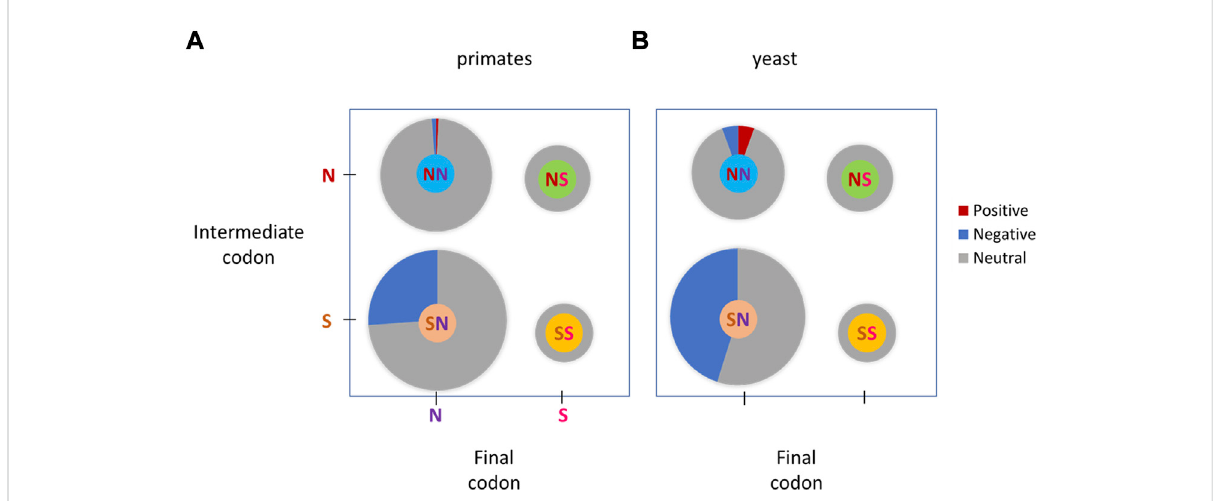
FIGURE 4 Selective pressure in different codon double substitutions classes. Positive, combinations compatible with positive selection, where a codon double substitution has a signi fi cantly higher DF than the corresponding DF of a null model (NM1 or NM2). Negative, combinations compatible with purifyingselection,whereacodondoublesubstitutionhasasigni fi cantlylowerDFthanthecorrespondingDFofanullmodel.Neutral,combinations, compatible with neutral evolution, where the codon DF was not signi fi cantly different from that of the corresponding DF of a null model. (A) , primates; (B) ,